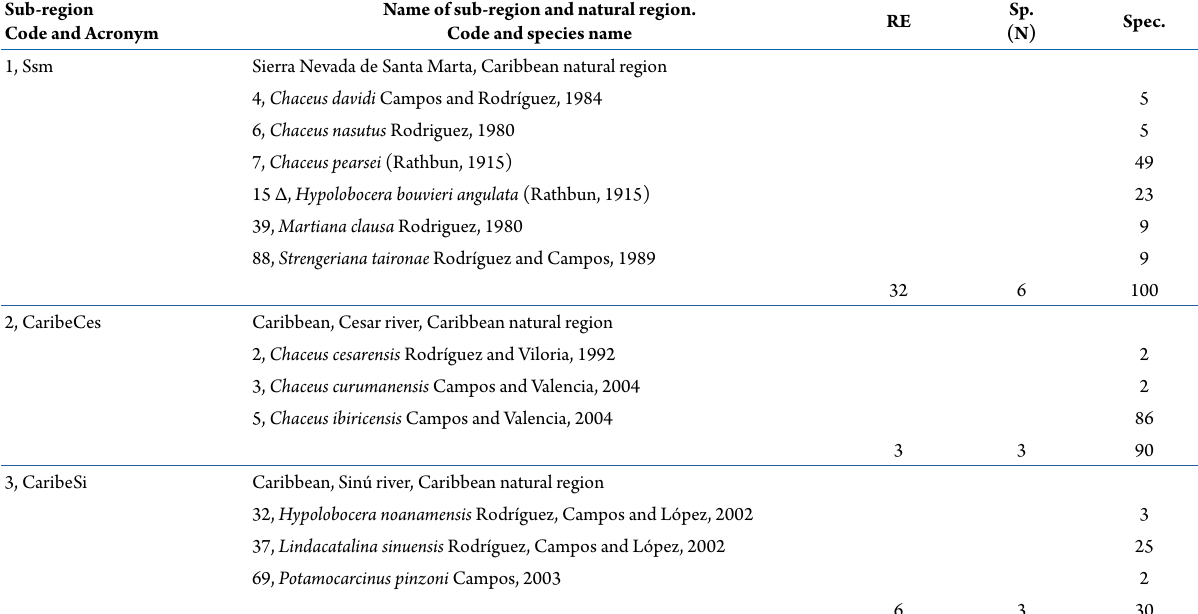
Table 2. Species of the family Pseudothelphusidae present in each one of the 75 sub-regions considered in this study. For each sub-region, it is specified: code and acronym (column 1), sub-region name and natural region to which it belongs. This is followed by (code, name) of the species recorded there (column 2), total numbers of records (RE) (column 3), number of species for each sub-region (column 4) and numbers of specimens (column 5). Symbol ∆ indicates a non-endemic species. Sub-region Name of sub-region and natural region. Code and Acronym Code and species